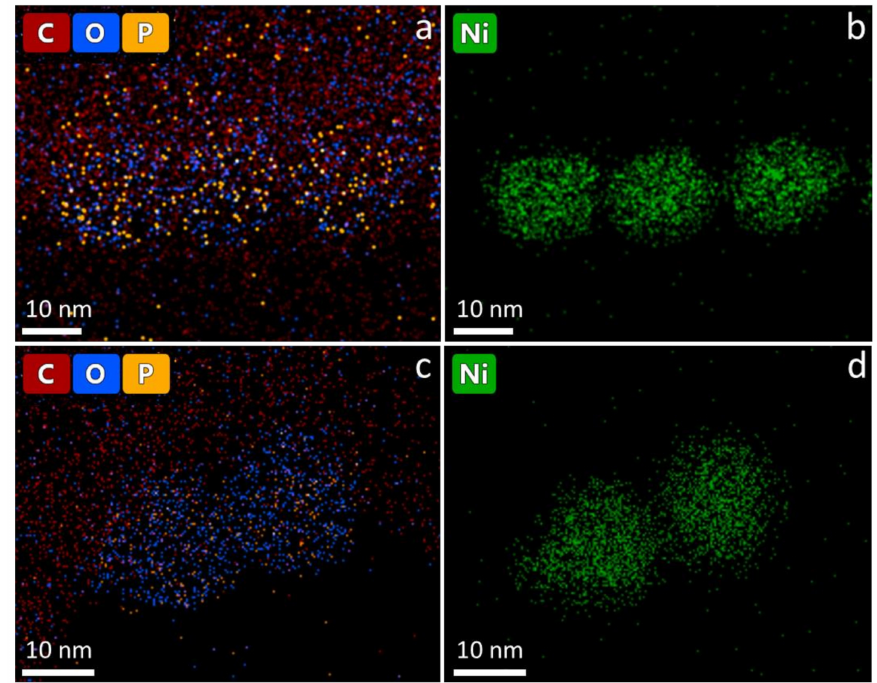
Figure 7. EDS mapping of NiNPs after synthesis: ( a ) Element distribution of carbon, oxygen, phosphorus, and ( b ) nickel. EDS mapping of NiNPs after nine weeks storage in air: ( c ) Element distribution of carbon, oxygen, phosphorus and ( d )